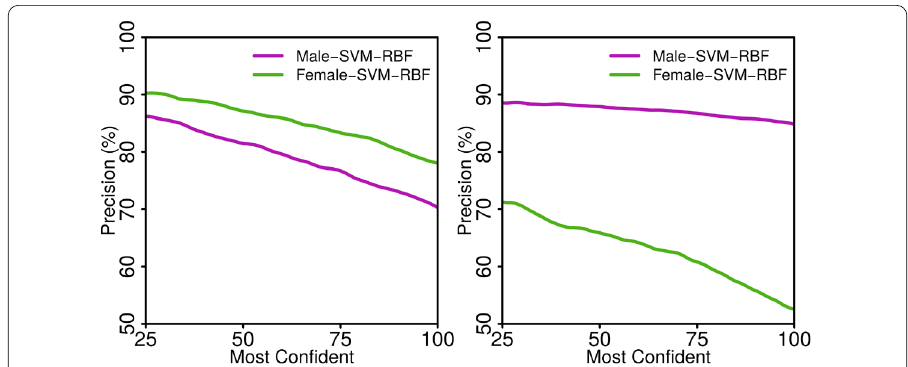
Figure 5 Precision for finding women (and men) in EU (left) and SA (right) as a function of the percentage of women that are in the dataset and which we are trying to find. The precisions are highly influenced by how balanced the datasets are. Our method reaches much higher precision than random (54% in EU and 29% in SA).